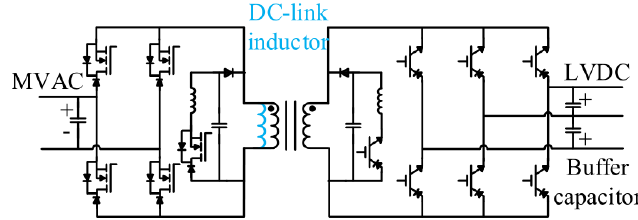
Figure 8. Soft-switching SST in AC/DC configuration [33].